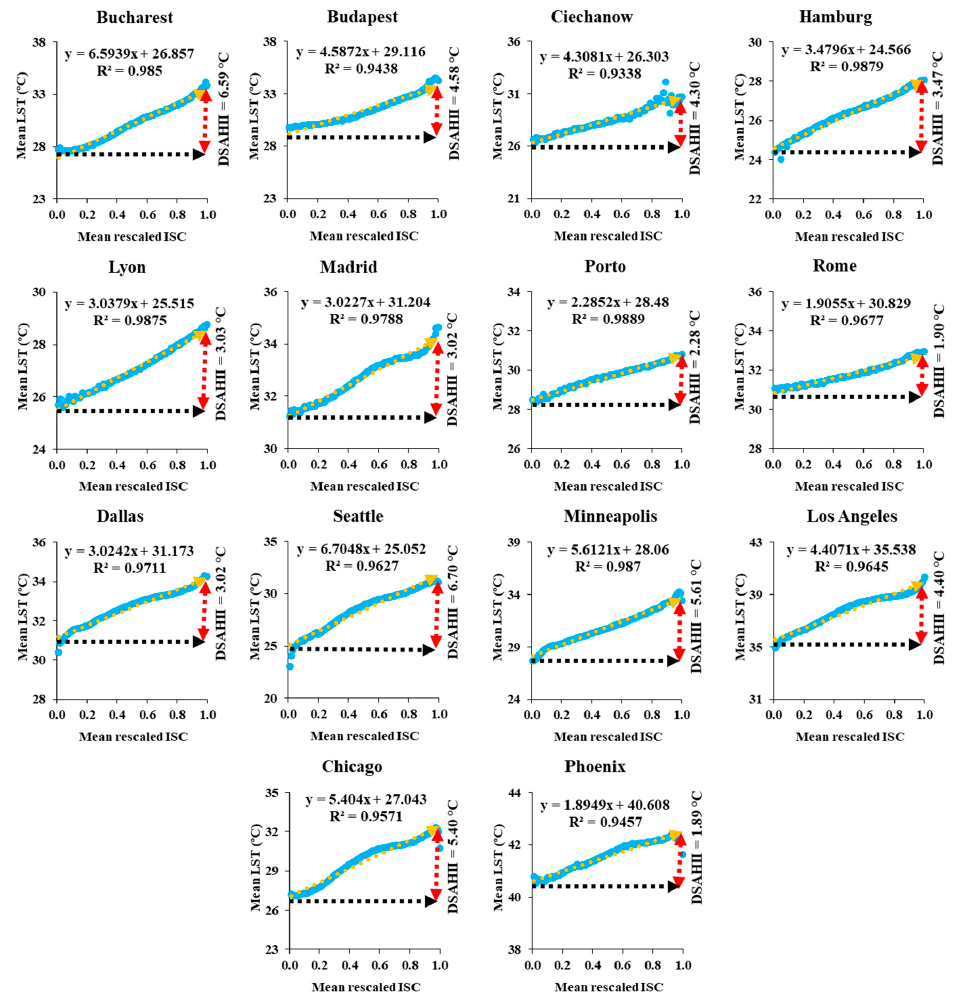
Figure 6. The mean value of DSAHII obtained from the LST-ISC feature space for selected cities in Europe and USA on different dates.